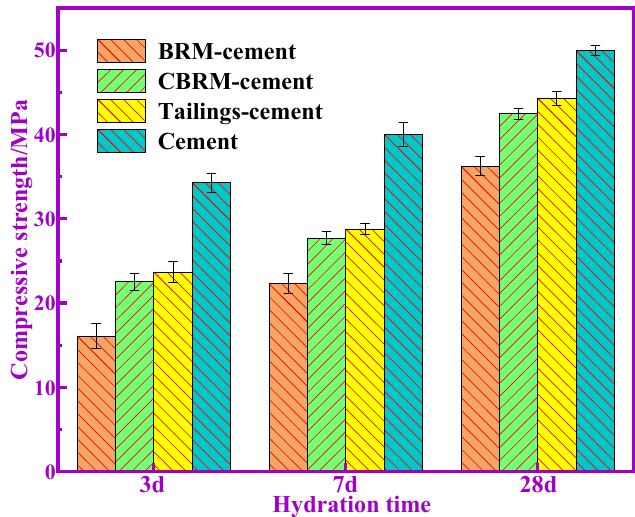
Figure 2. Compressive strength of cementitious materials.